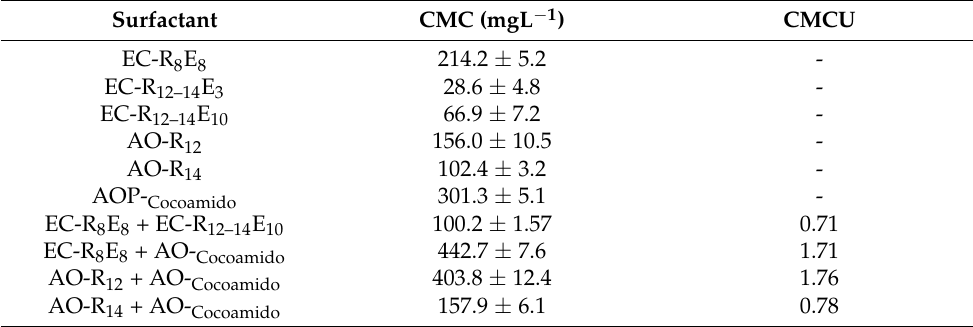
Table 2. CMC (95% CI) and CMCU of surfactants and surfactants mixtures (1:1 w / w ).